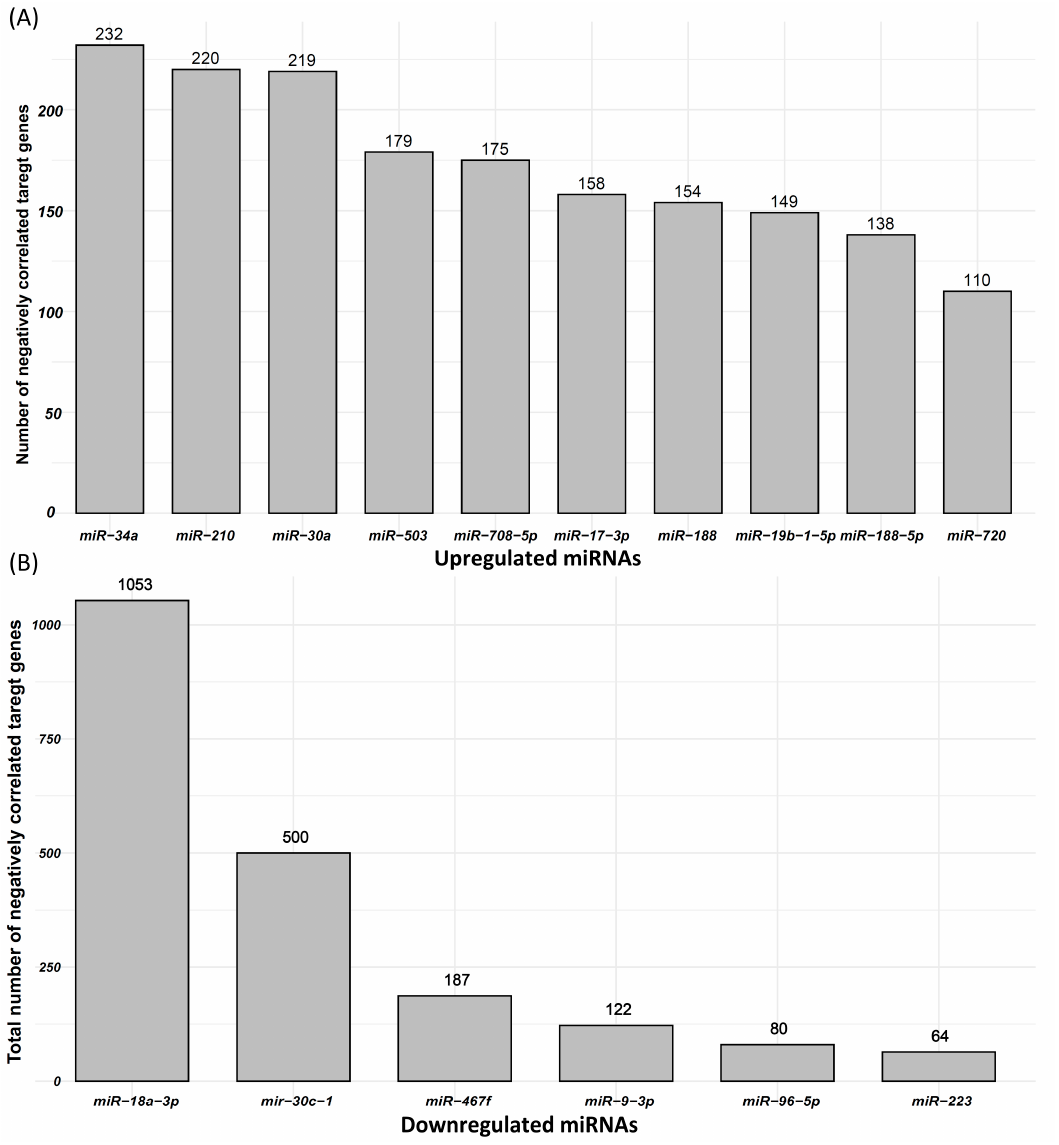
Figure 4. Differentially expressed miRNAs and their negatively correlated potential target genes. ( A ) Top 10 upregulated miRNAs and the number of their negatively correlated and downregulated target genes. ( B ) Downregulated miRNAs and the number of their negatively correlated and upregulated target genes.